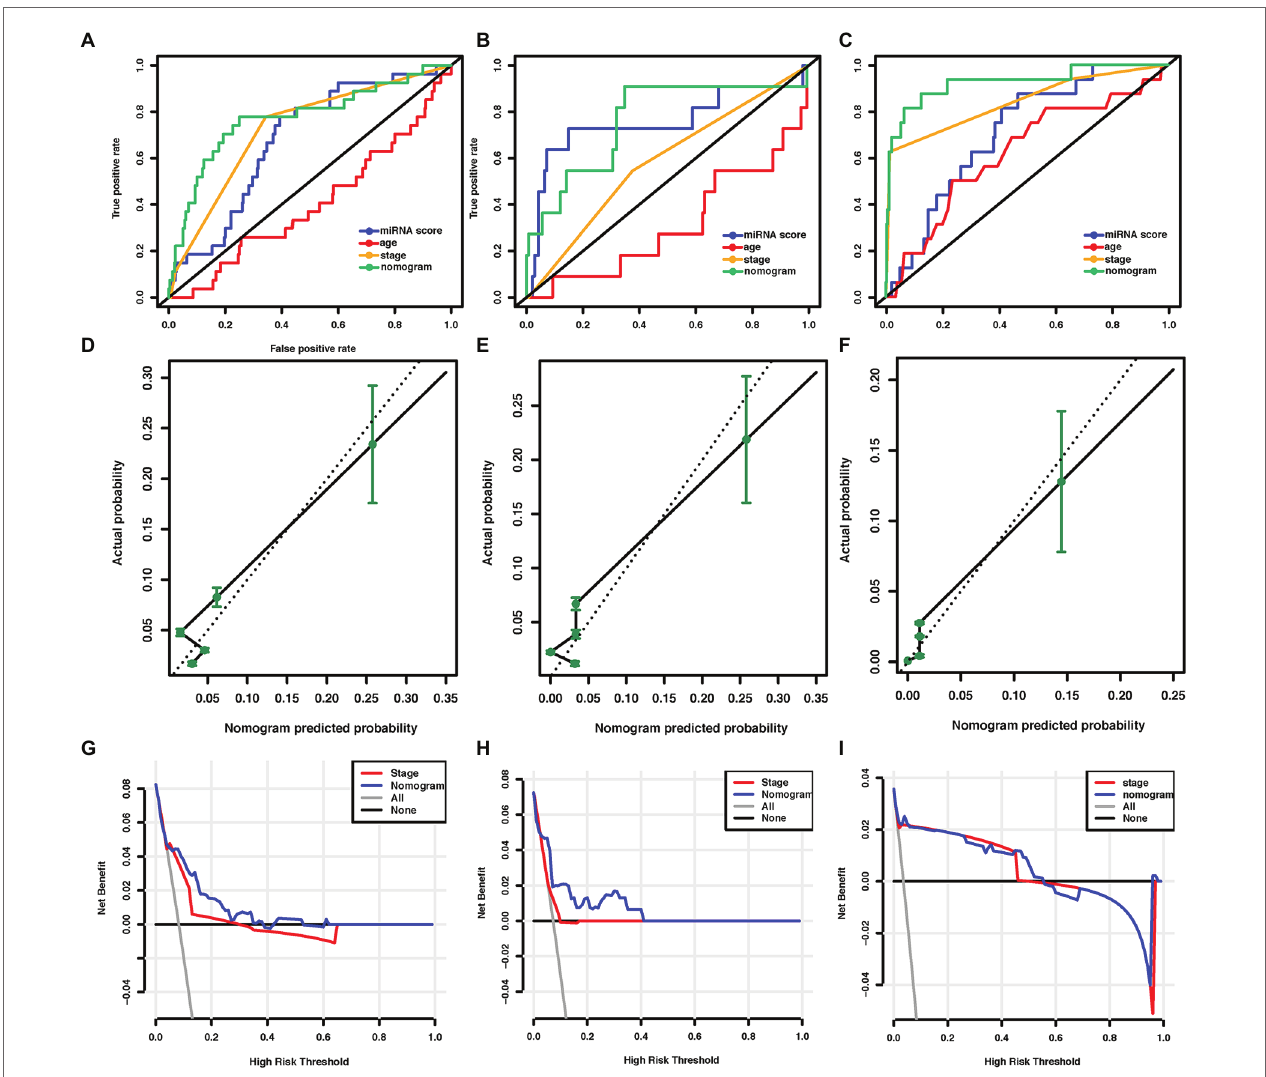
FIGURE 4 | Assessment of the miRNA-based nomogram. Receiver operating characteristic (ROC) curves of eight-miRNA signature, age at diagnosis, stage, and the miRNA-based nomogram model predicting LM in (A) training cohort, (B) internal validation cohort, and (C) external validation cohort. Calibration plots for miRNA- based nomogram model predicting LM in the (D) training cohort, (E) internal validation cohort, and (F) external validation cohort. Calibration curves depict the calibration of the model in terms of the agreement between the predicted risks of LM and the observed outcomes of LM. The y-axis represents the actual LM rate. The x-axis represents the predicted LM risk. The dashed line (the 45-degree diagonal line) represents a perfect prediction by an ideal model, and the black solid line represents the performance of the nomogram of which a closer fit to the diagonal dotted line represents a better prediction. Decision curve analysis of the miRNA- based nomogram model and tumor staging system in (G) training cohort, (H) internal validation cohort, and (I) external validation cohort. The y-axis displays the net benefit. Solid black line: net benefit when all breast cancer patients are considered as not having the LM; solid gray line: net benefit when all breast cancer patients are considered as having LM. Solid red line: net benefit when all breast cancer patients are considered according to the tumor staging system. Solid blue line: net benefit when all breast cancer patients are considered according to the miRNA-based nomogram model. The net benefit was calculated by subtracting the proportion of all patients who are false positive from the proportion who are truly positive, weighting by the relative harm of giving up treatment compared with the negative consequences of unnecessary treatment (Vickers et al., 2008). miRNA, microRNA; ROC, receiver operating characteristic; LM, lung metastasis; and BC, breast